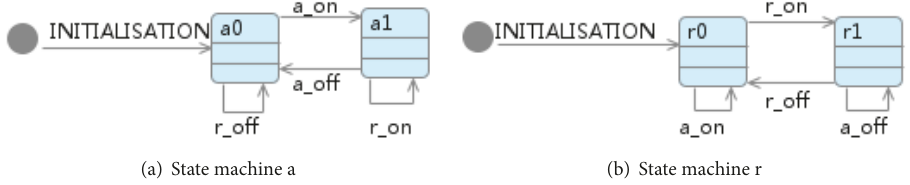
Figure 11: The iUML-B state machines of the strong synchronization pattern.